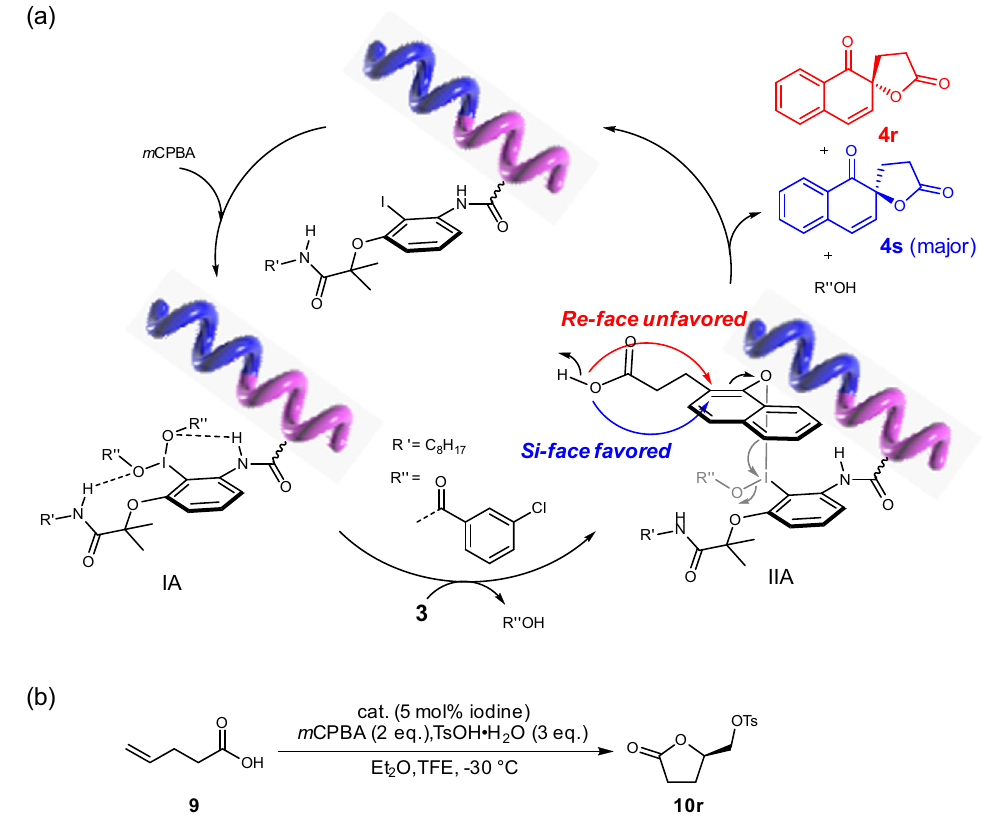
Fig.5|Mechanismstudyandasymmetricsulfonyl-oxylactonization.a ProposedmechanismforasymmetricKita-Spirocyclizationcatalyzedbyhelicalpolyisocyanides. b Asymmetric sulfonyl-oxylactonization catalyzed M -poly(L- 1 150 - b - 2 10